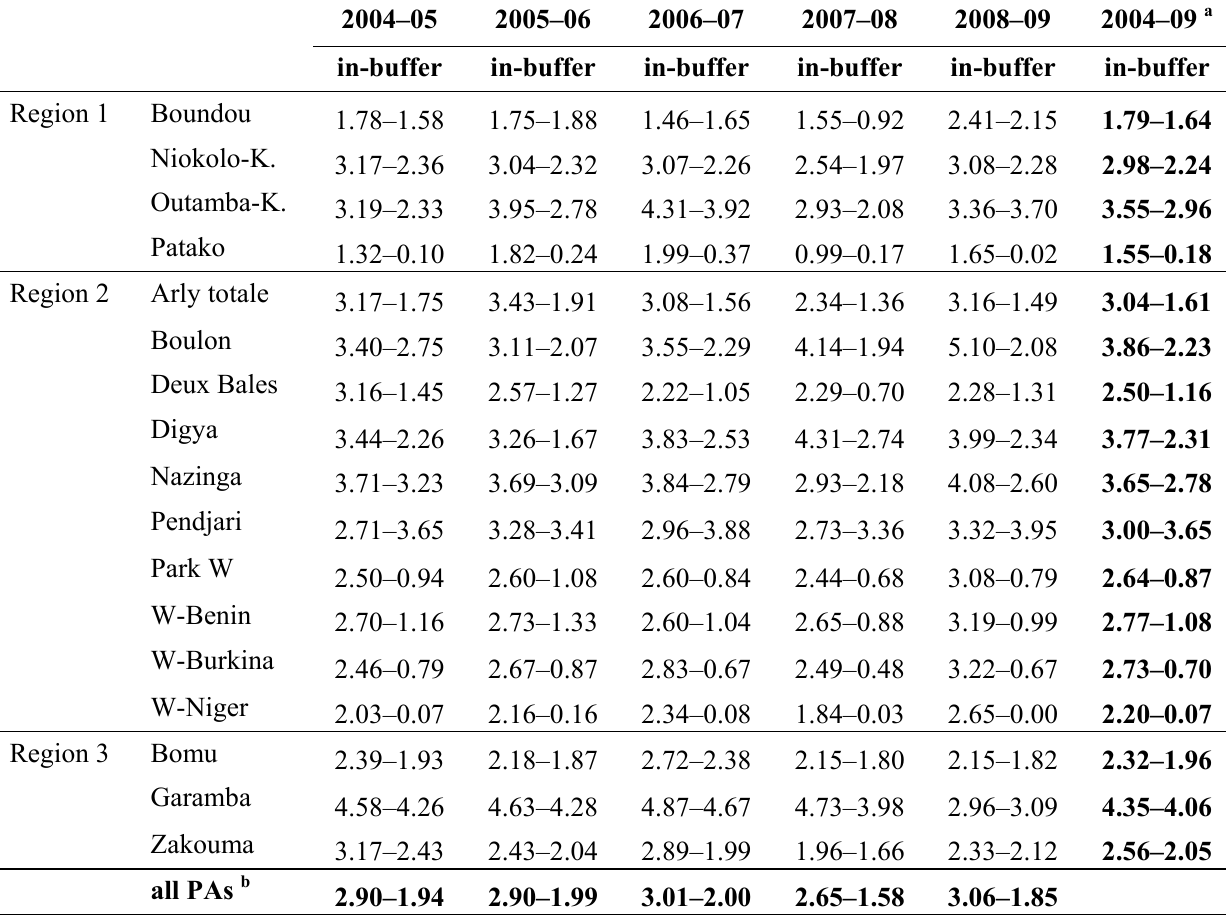
Table 3. Fire density in the 17 PAs (in) and in their 25-km buffer for five dry seasons from 2004 to